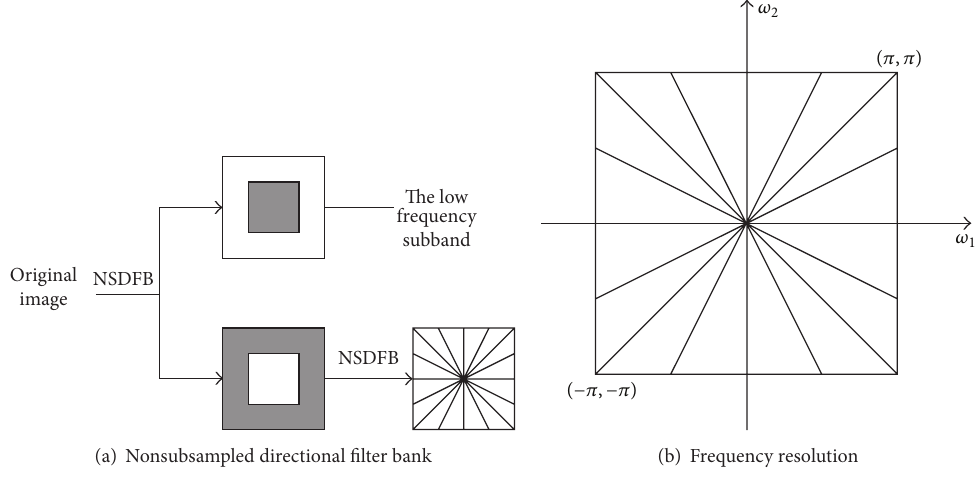
Figure 1: The structure of nonsubsampled Contourlet